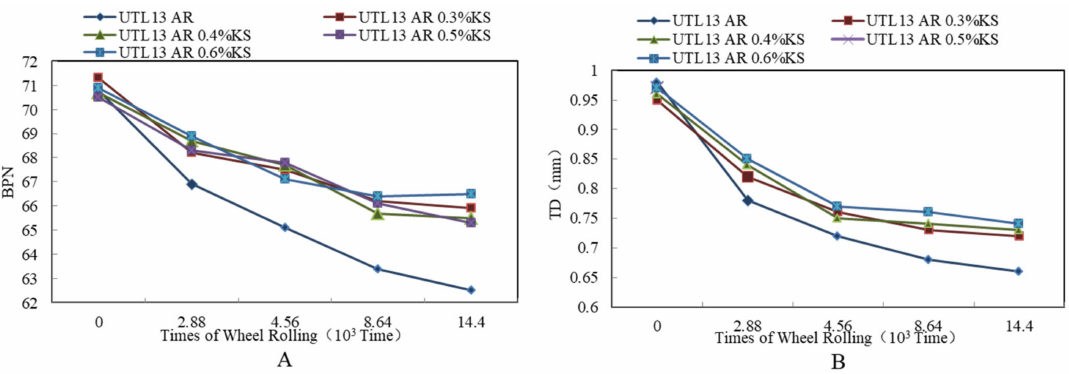
Figure 14. Attenuation rules of skid resistance indexes with di ff erent KS contents: ( A ) BPN; ( B )